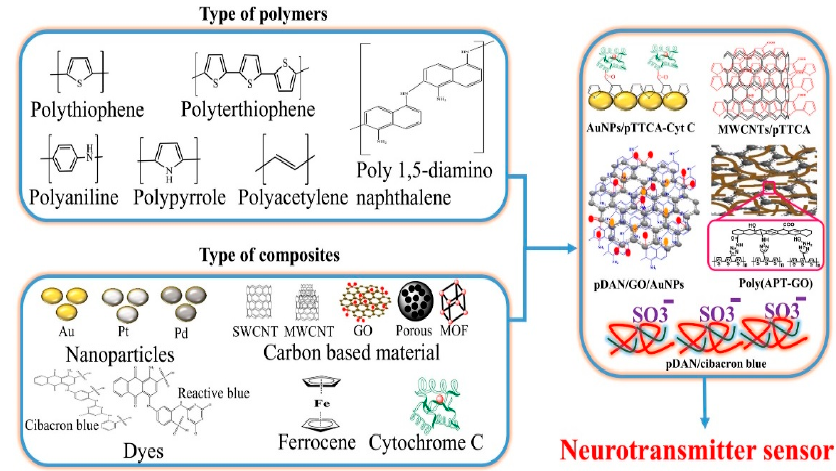
Figure 5. Schematic representation of various types of conducting polymers, nanomaterials and their bio-nanocomposites. (Reproduced here with copyright permission [97]).